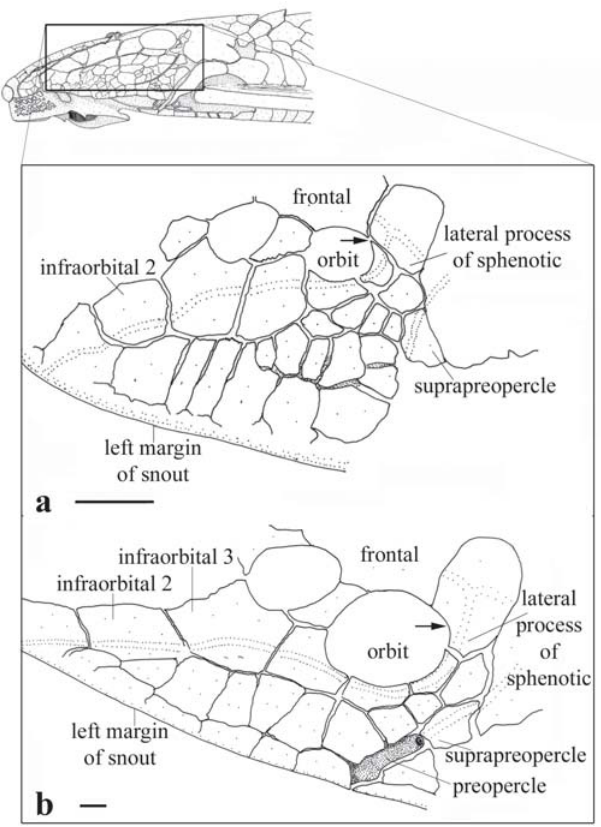
Fig. 20. Lateral view of region of snout and orbit (left side) of Pterosturisoma microps (MZUSP 79909, 75.9 mm SL) (a) and Sturisoma sp. (MZUSP 50112, 115.2 mm SL) (b). Arrow points to margin of sphenotic that borders the orbit. Scale bar = 2 mm.